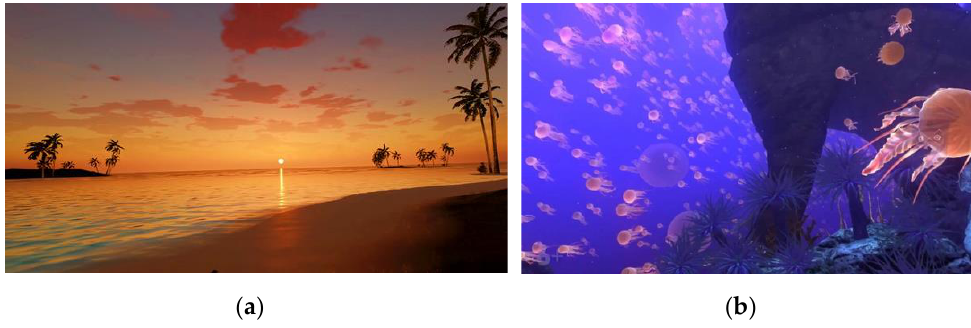
Figure 3. Screenshots of some immersive virtual scenarios proposed for first contact with IVR. ( a ) Sunset environment placed in a beach; ( b ) Seabed with Jellyfish.